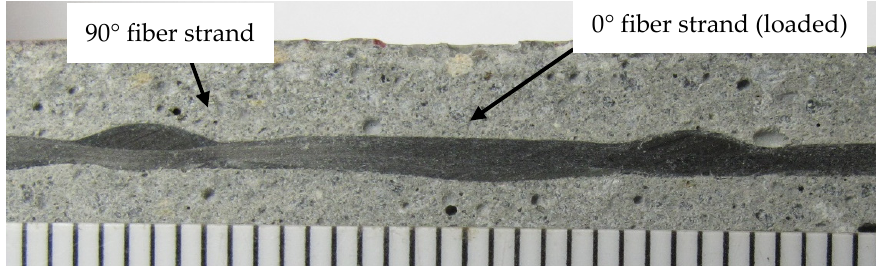
Figure 6. Impregnated textile embedded in fine grained concrete.